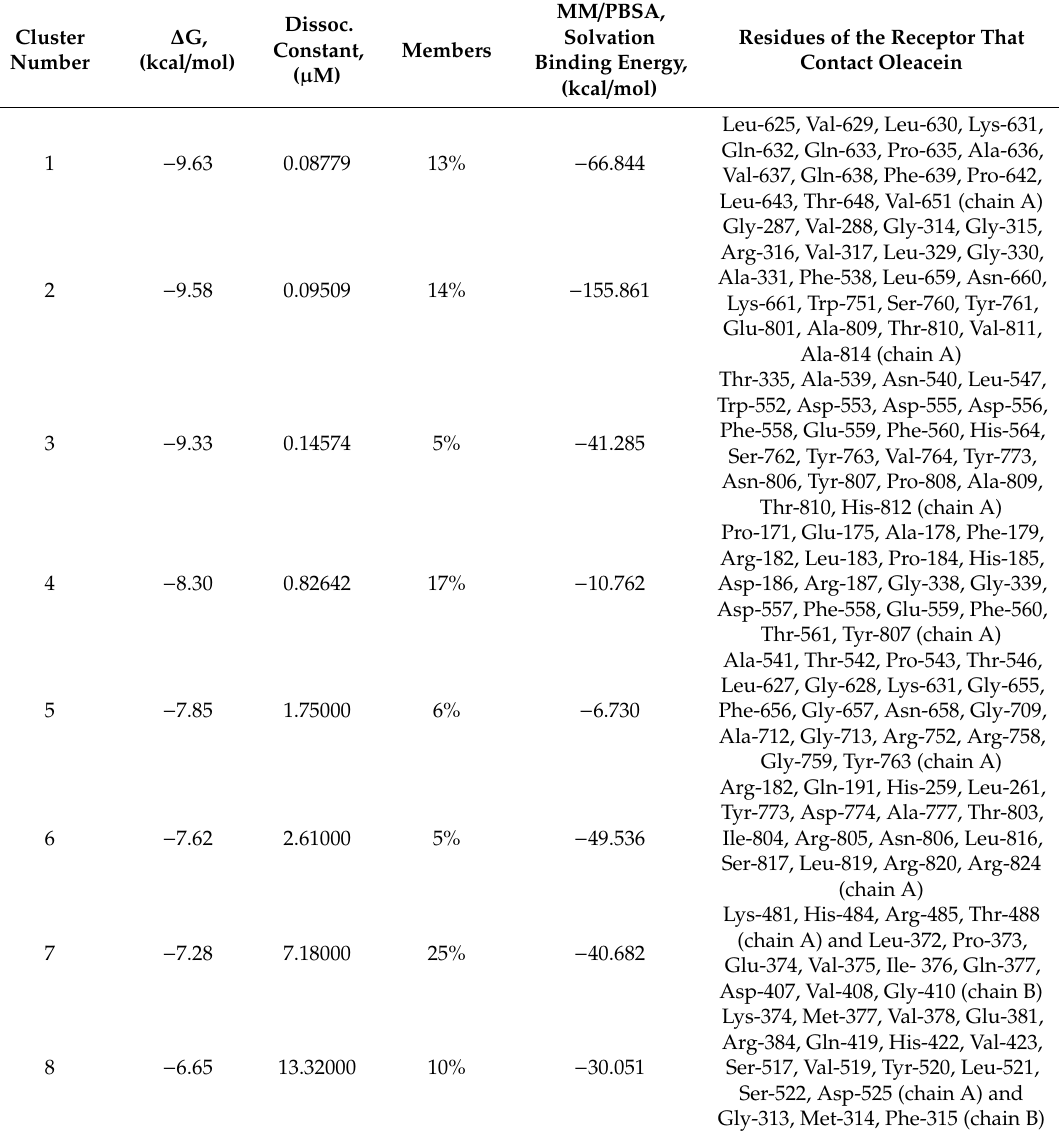
Table 2. Interactions between oleacein and the LSD1-CoREST-histone H3 complex (PDB: